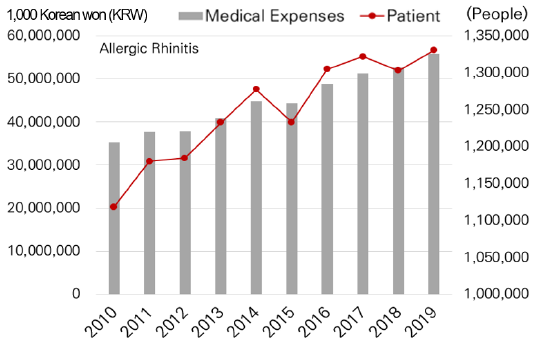
Figure 5. Allergic rhinitis patient and medical expenses.